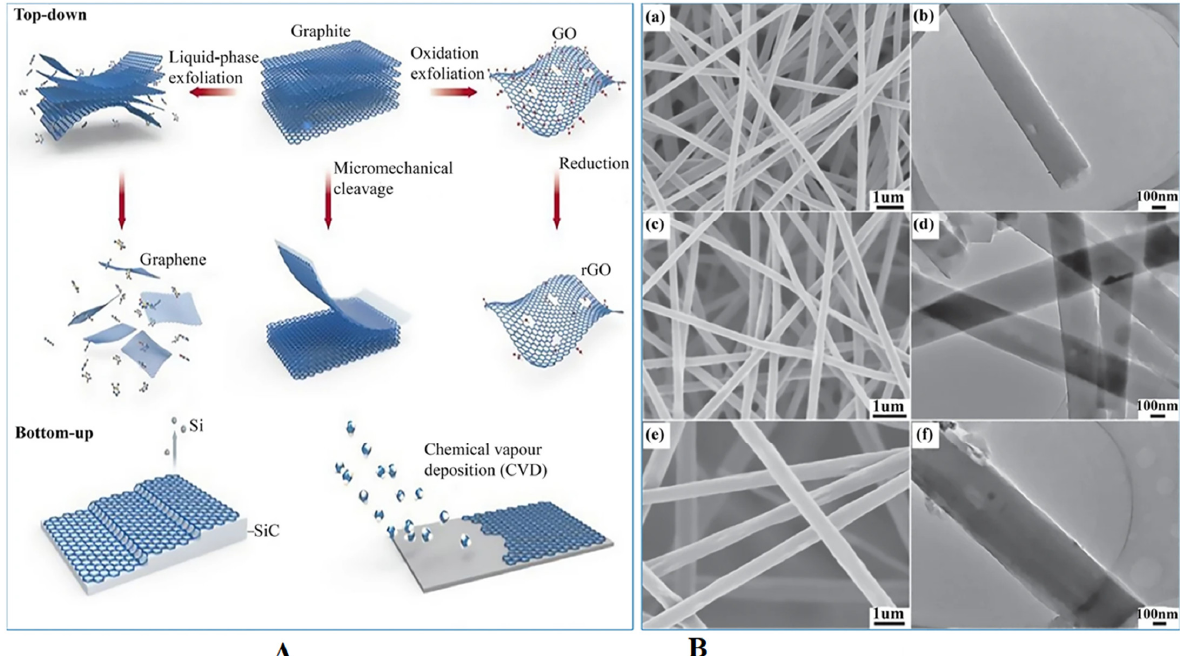
Figure 2. ( A ) Major fabrication methods of graphene: Top-down and bottom-up fabrication methods. Principal top-down methods include liquid-phase exfoliation and micromechanical cleavage of graphite. An additional method involves the exfoliation of initially oxidized graphite, leading to GO, which is chemically and/or thermally reduced to graphene. The bottom-up fabrication of graphene is usually performed by epitaxial growth on SiC or chemical vapor deposition, typically on Cu using small molecules, such as methane, as precursors. Reproduced with permission from [104]. Copyright Springer Nature 2020. ( B ) SEM ( a , c , e ) images and TEM images ( b , d , f ) of NFs ( a , b ), NFs-rGO-5 ( c , d ), and NFs-rGO-10 ( e , f ) with different magnifications. Reproduced with permission from [104]. Copyright 2019 Wiley.